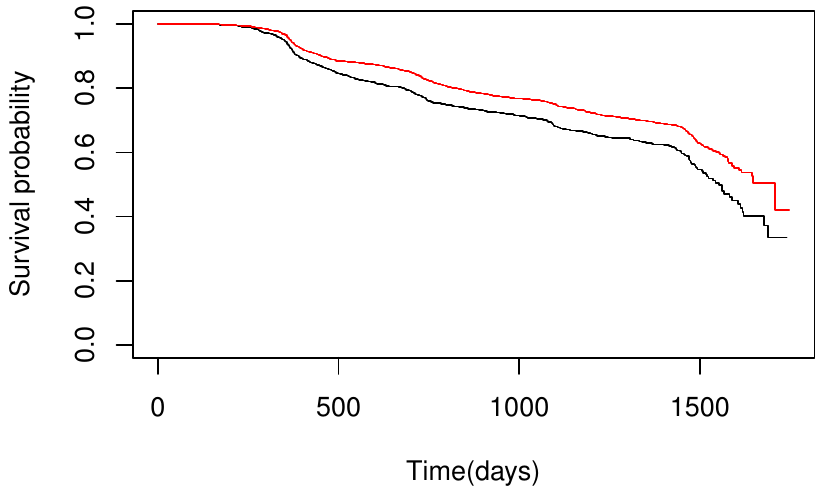
Figure 4. Kaplan–Meier estimator of the survival function for the onset of hypertension for each gender. The black and red lines represent the estimators for males and females,